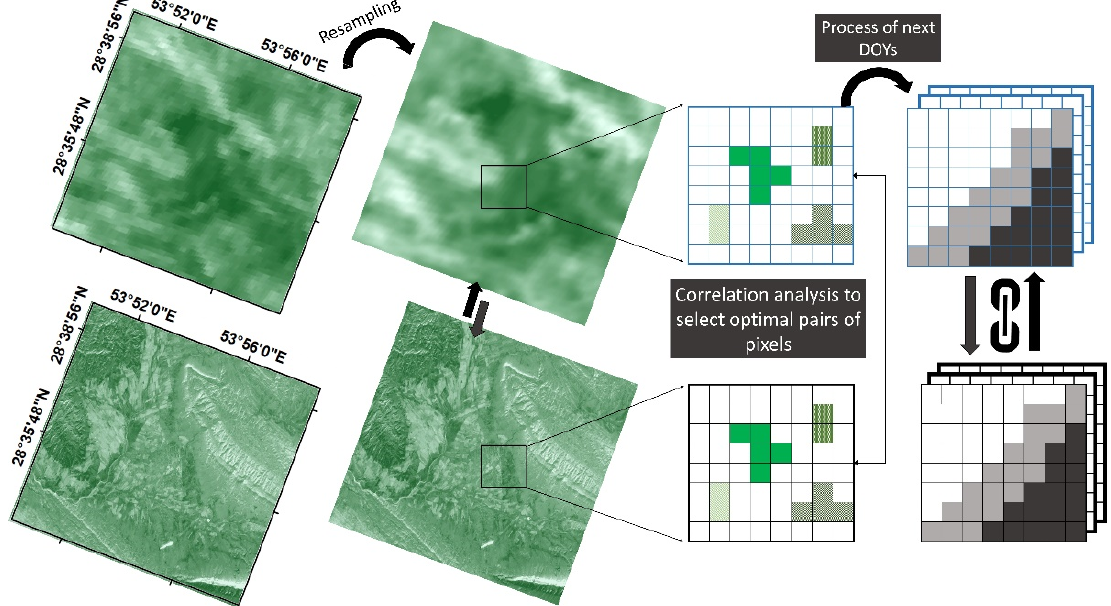
Figure 3. Schematic view of the selective filter used in the fusion model over the study region.